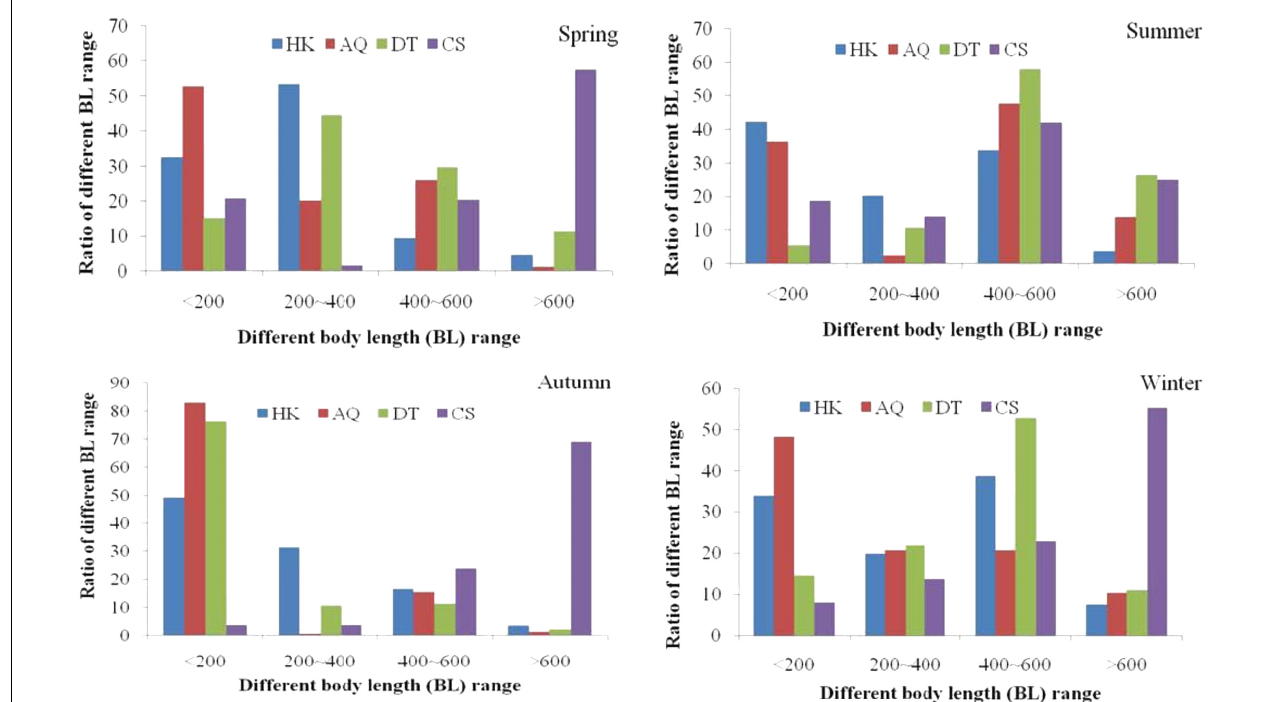
FIGURE 3 | Body weight range ratio in different